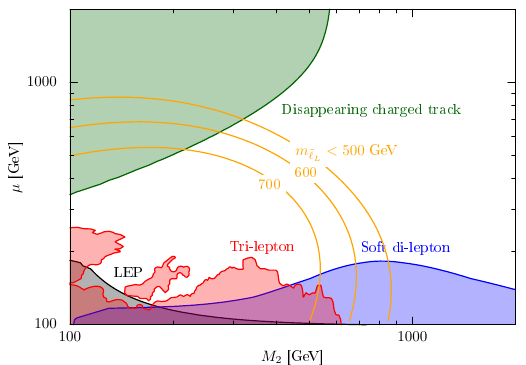
Figure 5. The current collider constraints on the Higgsino-Wino system. The orange lines show the rough upper limits on the left-handed slepton mass to explain the observed a